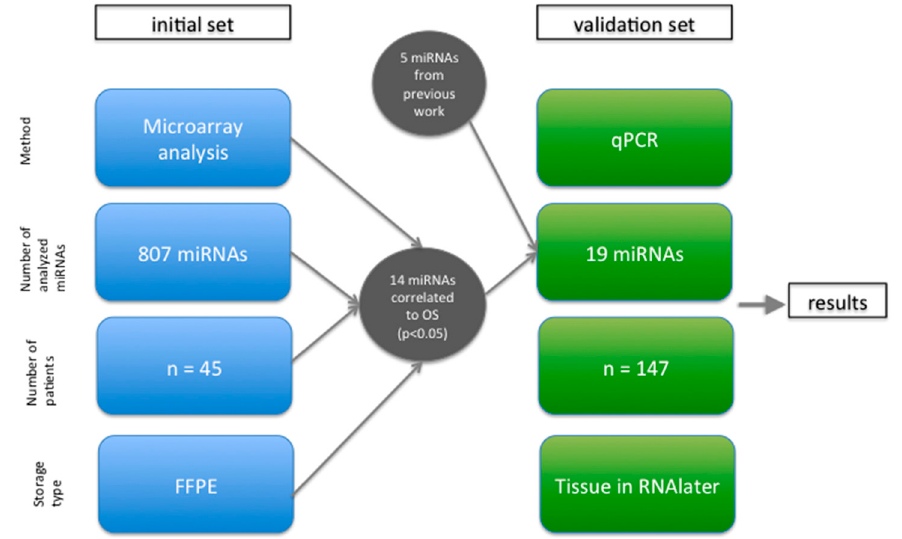
Figure 4. Study design: On the left, the initial set of 45 patients’ formalin-fixed paraffin-embedded (FFPE) samples analyzed via microarray analysis is shown. The results of that analysis showed a significant correlation ( p < 0.05) of 14 miRNAs to overall survival (OS). These miRNAs together with 5 further miRNAs from previous work were analyzed in 147 patients’ samples (preserved in RNAlater), which were analyzed via quantitative real-time polymerase chain reaction (qPCR). The results are explained in the result paragraph.